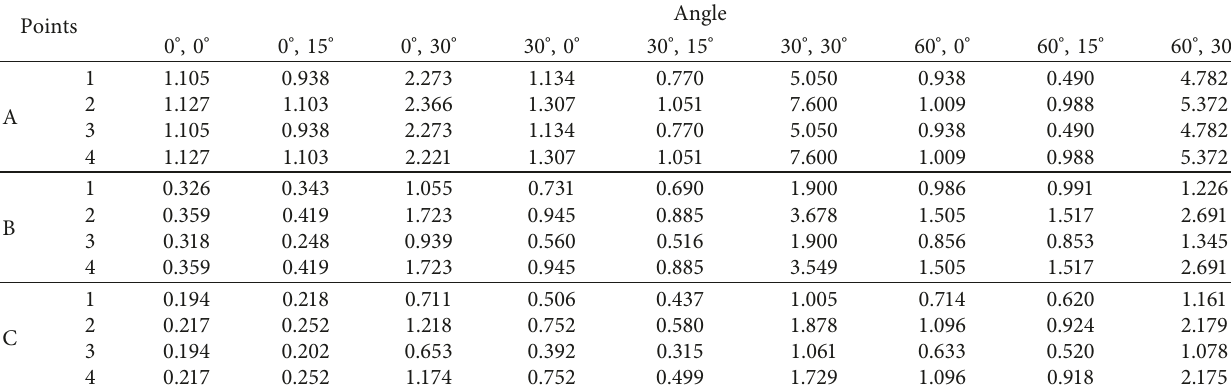
Table 6: Shear stress (MPa).